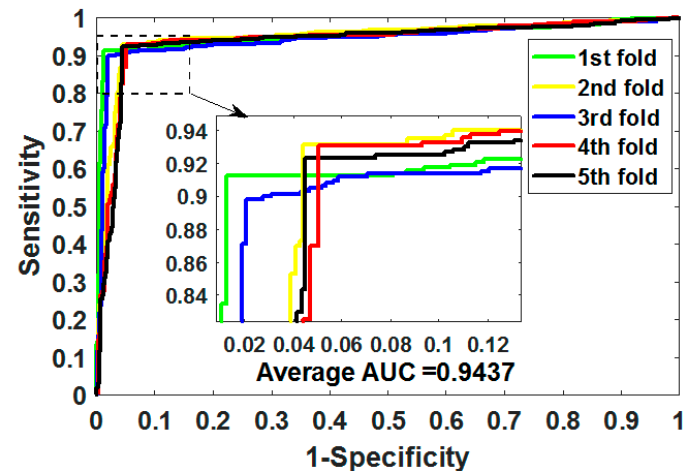
Figure 2. ROC of 5CV mapped by MSPEDTI on enzyme dataset.